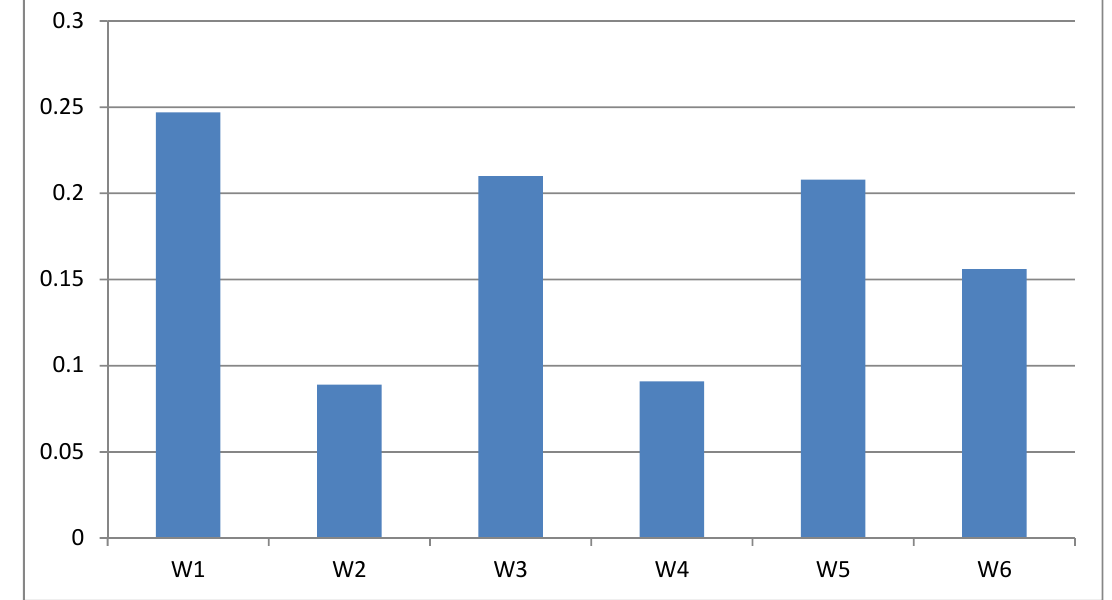
Fig. 2. Criteria weights (W1= balance of life and work W2= ability to do different jobs simultaneously W3= ability to relate to others fast and positively W4= patience at work and taking risks W5= self-assurance and eagerness at work W6= accuracy and stability in activities).